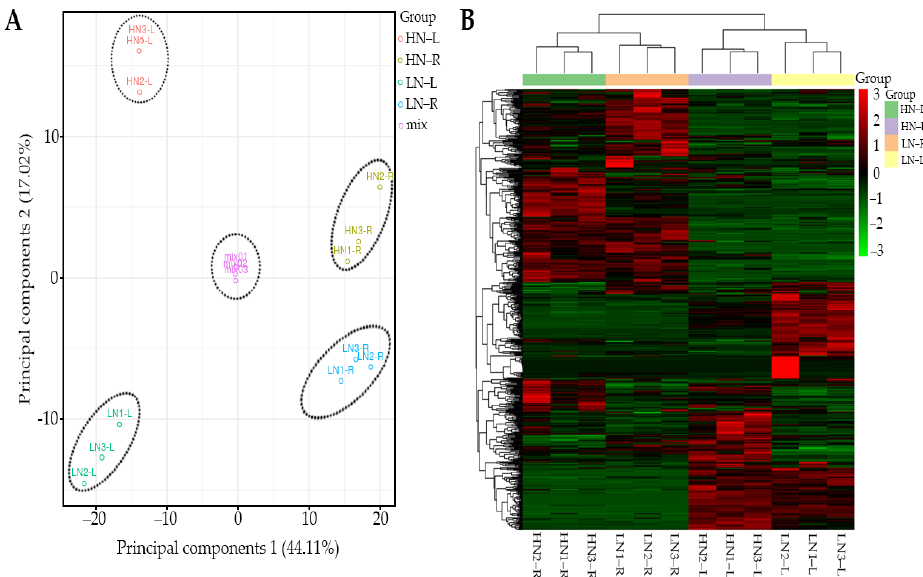
Figure 2. PCA and heatmap analysis of all metabolites detected in the leaves and roots of rapeseed under HN or LN conditions. ( A ) PCA score plots were derived from the relative contents of all detected metabolites by LC–ESI–MS/MS, with six replicates per treatment. ( B ) Heatmap showing 574 differentially accumulated metabolites of the leaves and roots between HN and LN conditions. The values of the metabolites were normalized and are shown as a color scale. The high and low metabolite levels are represented as red and green scales, respectively.